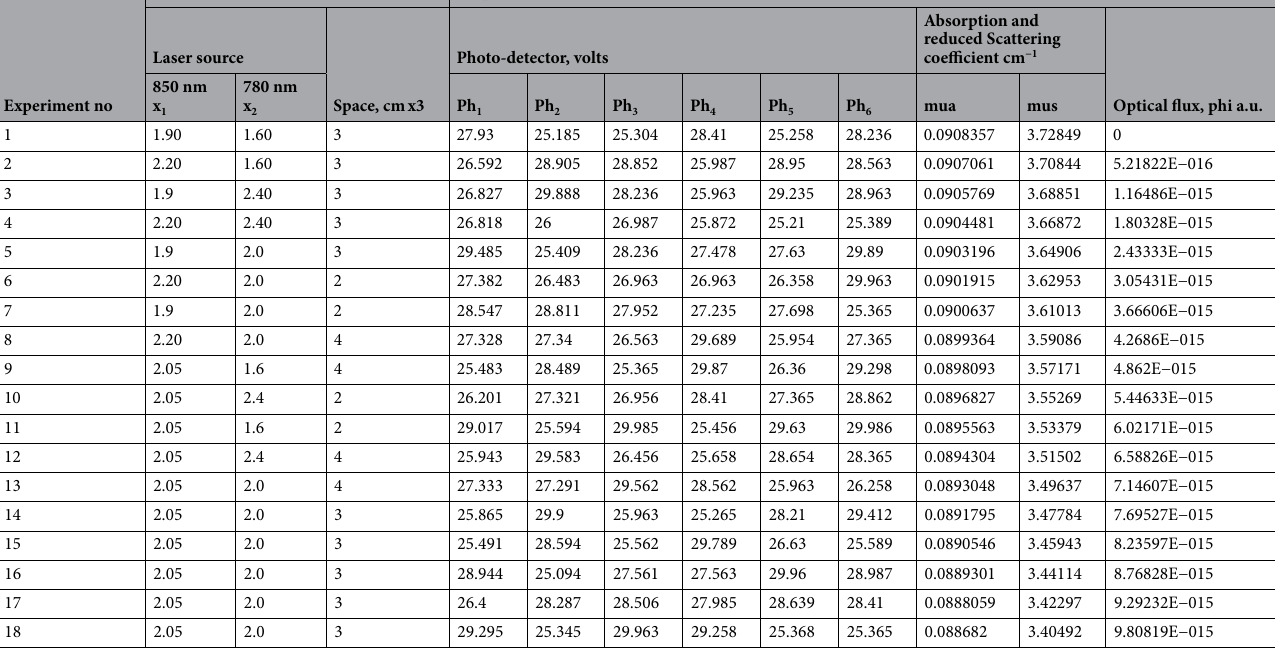
Table 2. Design matrix concerning each response